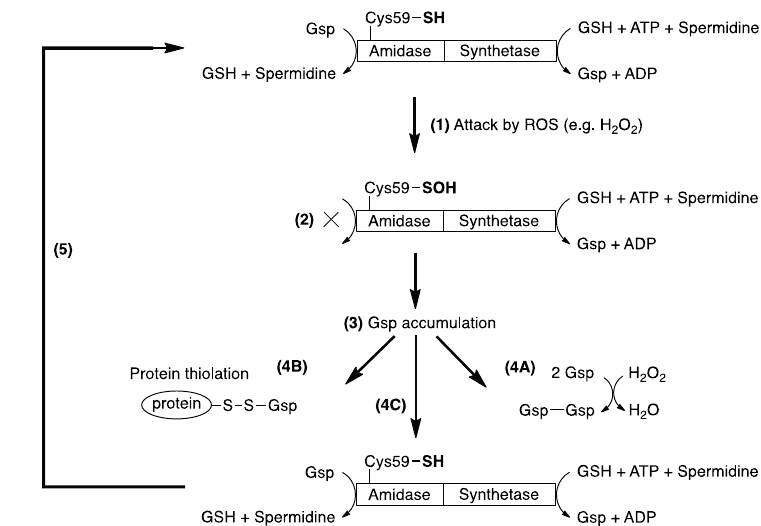
Figure 3. ( a ) Cysteine thiols can be oxidized by different oxidants to form sulfenic